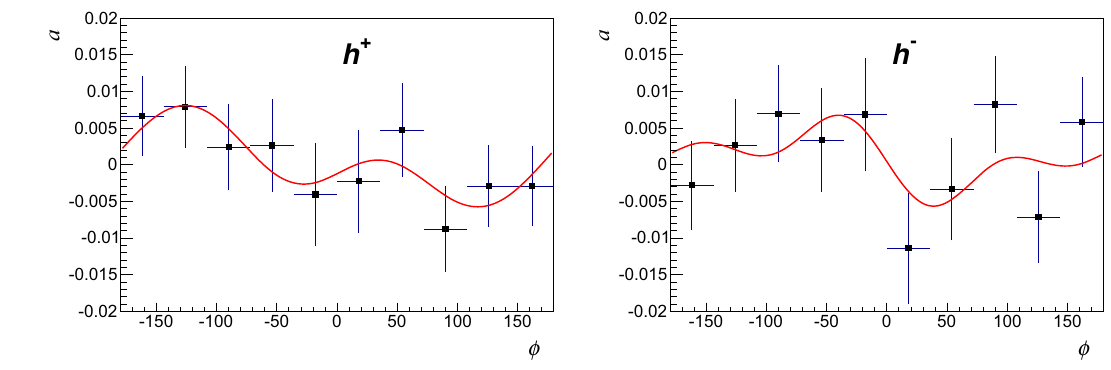
Fig. 4 The 2006 “integrated” asymmetries a as functions of the azimuthal angle φ . Curves show the corresponding fits Table 2 The h + and h − modulation amplitudes of the integrated azimuthal asymmetries obtained from the statistically combined amplitudes of the 2002–2006 (left), those of 2002–2004 (middle) and those of 2006 (right) Modulation amplitudes